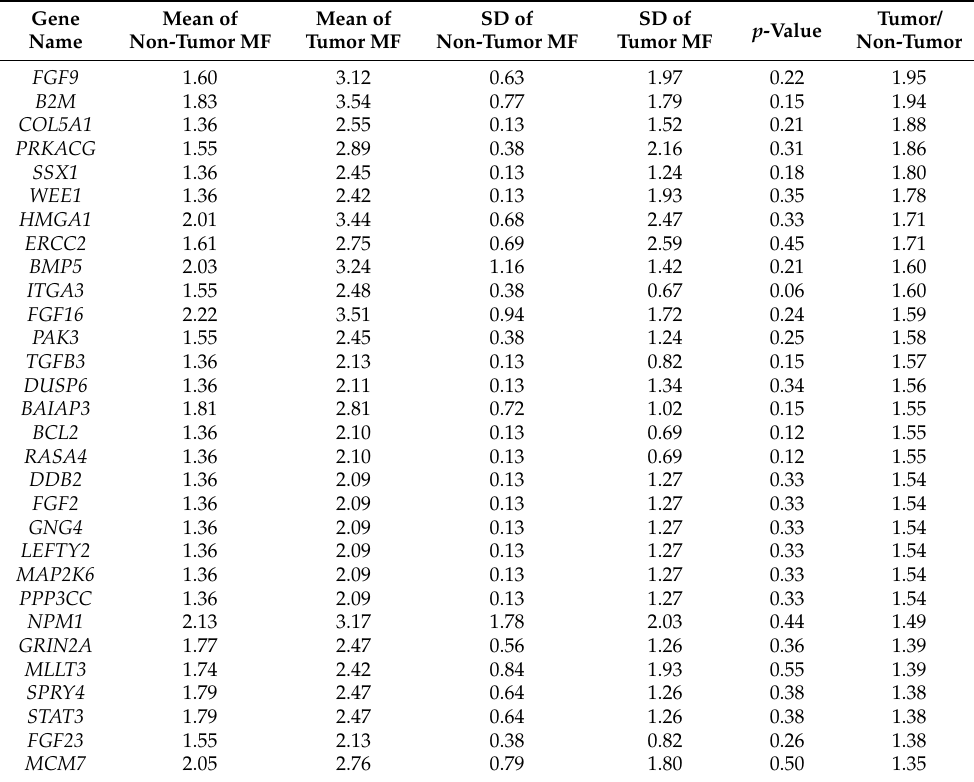
Table 1. Summary of the 30 genes most upregulated in tumor MF based on the tumor/non-tumor MF ratio.